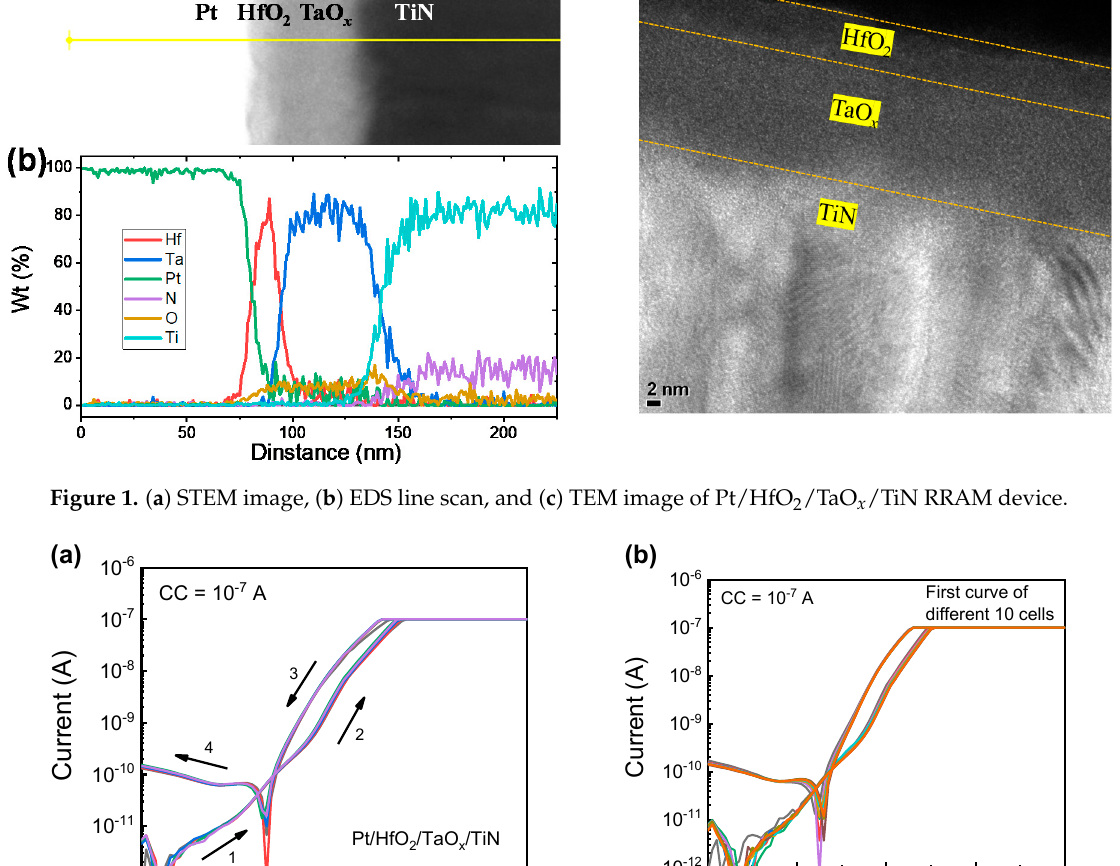
Figure 1. ( a ) STEM image, ( b ) EDS line scan, and ( c ) TEM image of Pt/HfO 2 /TaO x /TiN RRAM device.